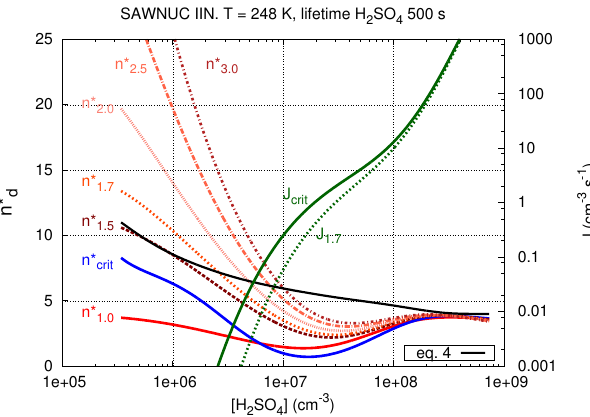
Fig. 2. Influence of an ion-induced nucleation channel and a sink for small particles on the interpretation of measurements of particle formation rates. The minimum in n ∗ is around 1 × 10 7 cm − 3 at 1.3. The labels and axis are the same as in Fig.